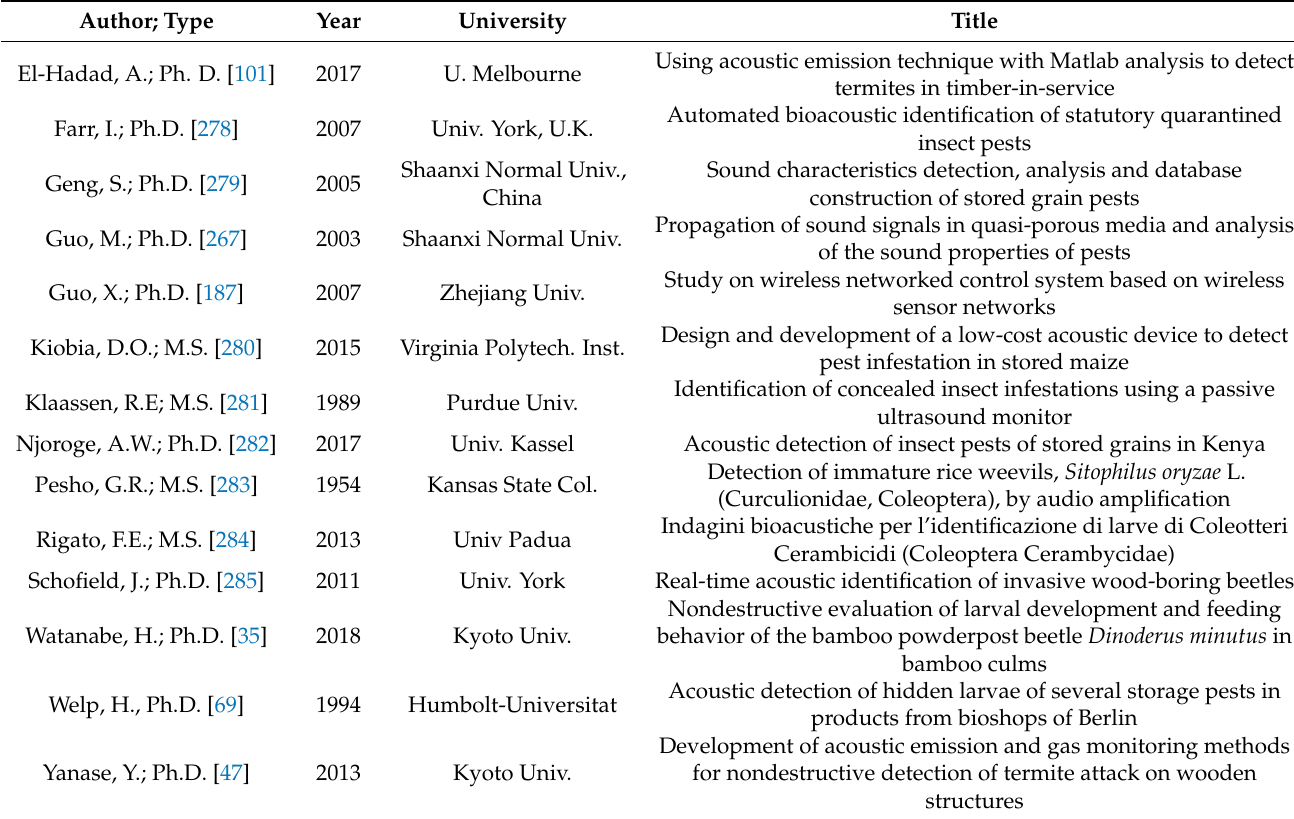
Table 5. Recent theses on insect acoustic detection and